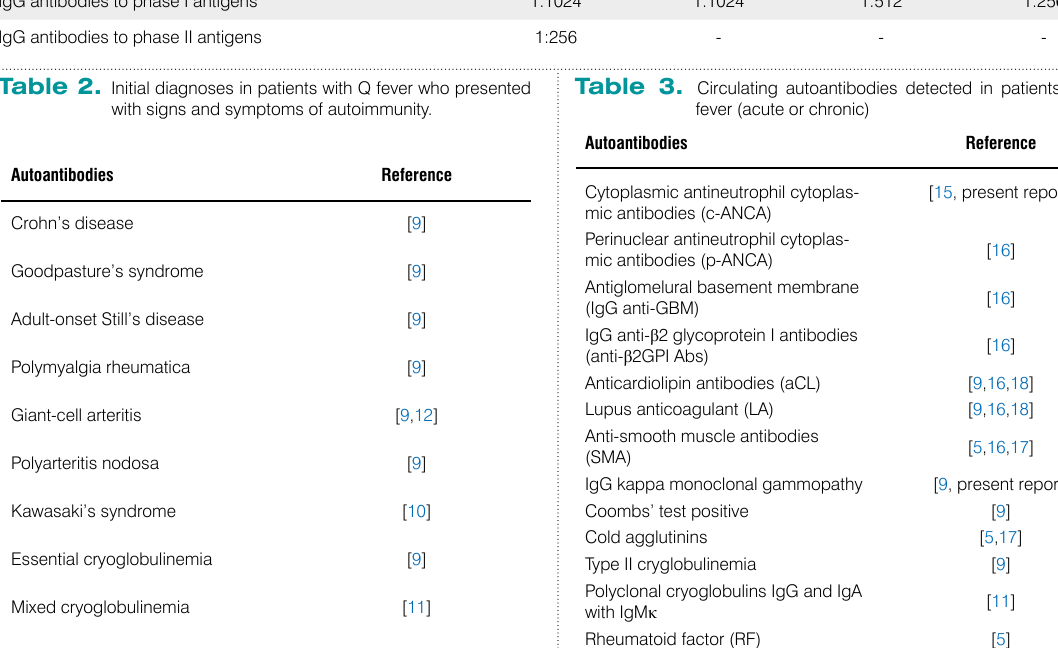
Table 3. Circulating autoantibodies detected in patients with Q fever (acute or chronic)